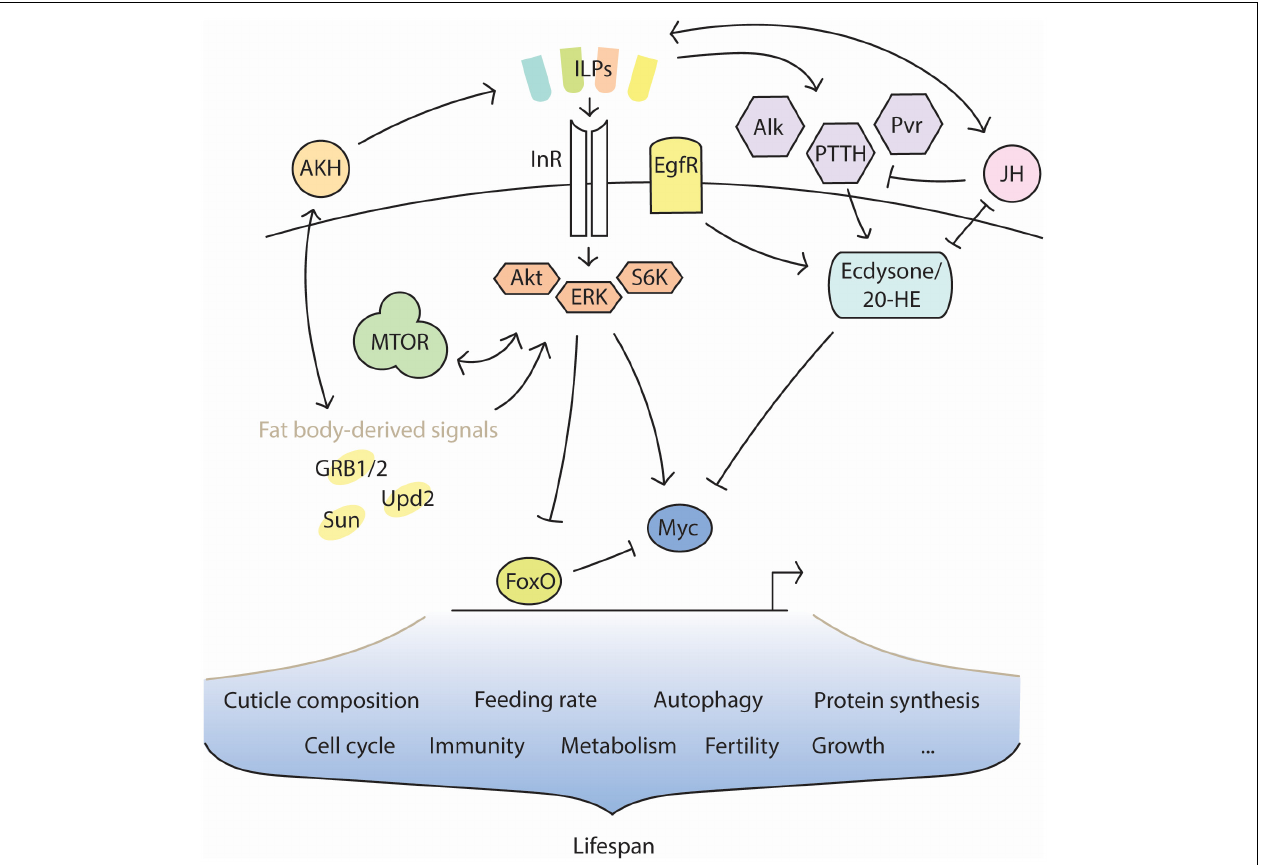
FIGURE 1 | Interaction of key factors in diapause. Insulin signaling profiles change in diapause, caused by the activity of different insulin-like peptides (ILPs). The ILP profile must remain dynamic in diapause to support the diapause-associated metabolism over time and changing conditions. Other factors, such as the nutrient-sensitive adipokinetic hormone (AKH) and the pro-reproductive juvenile hormone (JH), influence insulin signaling and are themselves influenced in turn. JH opposes the metamorphic action of ecdysone and its upstream regulators. FoxO is typically inhibited by insulin signaling, but is disinhibited during diapause. Conversely, the pro-growth transcription factor Myc is typically promoted by insulin signaling, but becomes inhibited during diapause. Many features of diapause physiology are regulated through interactions between insulin signaling, JH, ecdysone, and nutritive feedback signals from the fat body. The extended lifespan of insects in diapause is likely a product of these features’